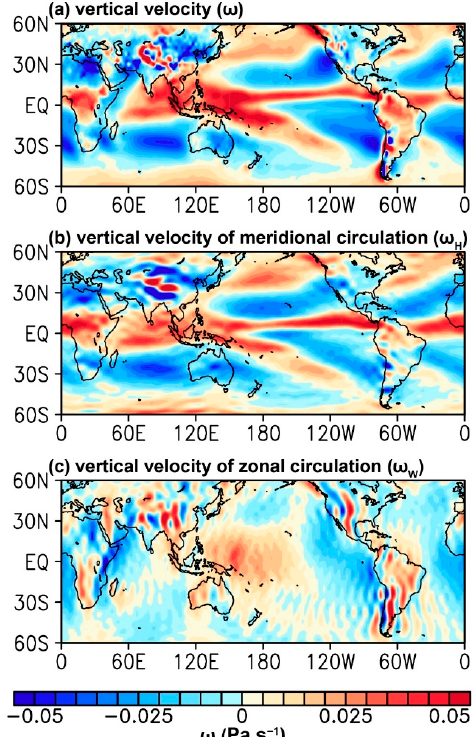
Figure 2. Mean state (1961–2012) of the annual mean ( a ) vertical velocity, ( b ) vertical velocity of the meridional circulation, and ( c ) vertical velocity of the zonal circulation at 500 hPa using the JRA-55 reanalysis dataset [35]. The vertical velocities have been multiplied by − 1, and positive (negative) values represent rising (sinking) motion. The unit for vertical velocity is Pa s − 1